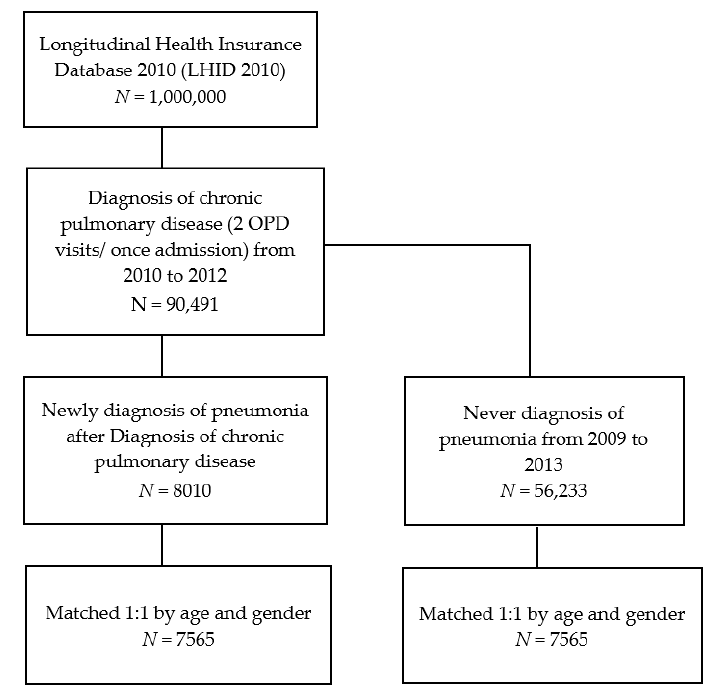
Figure 1. Flow chart for patient selection. Table 1. Demographic characteristics of pneumonia and non-pneumonia.